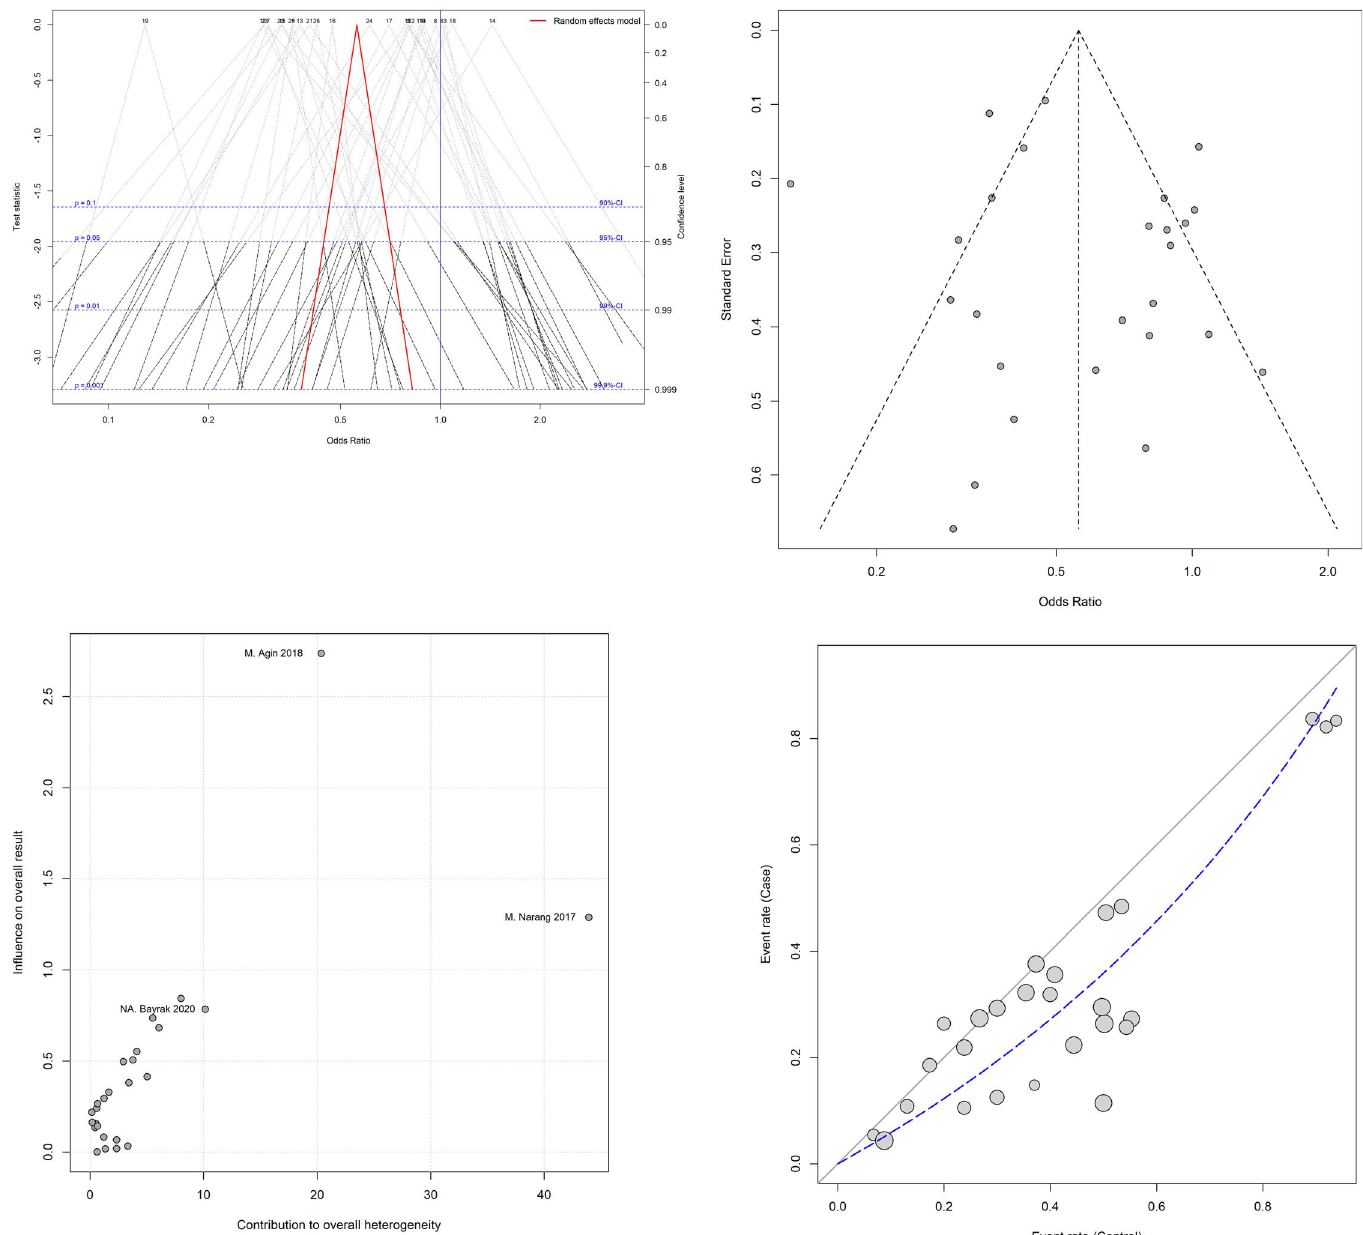
Fig 3. (A) The drapery plot shows p-value functions for the included studies as well as pooled estimates and the two-sided confidence intervals for all possible alpha levels (confidence interval function). Each number represents a study. The red-bolded line (in the online version; bold line in the printed version) indicates the range of pooled odds ratio (OR) in each alpha level. (B) The Funnel chart shows no significant publication bias, as all studies are in a symmetric scheme. (C) The Baujat plot shows the effect of each study on the heterogeneity and overall influence of the results. As can be seen in the graph, the study of Narang et al. contributes more than the other studies to the overall heterogeneity. Each circle represents a study. (D) The L’Abbe´ plot shows more positive results for H. pylori colonization in the control group. The diagonal (x = y) oblique line represents the odds ratio (OR) equal to one. The dashed line indicates the OR of the studies. The size of each circle indicates the assigned random weight of each study. As the picture shows, most studies show an OR of less than